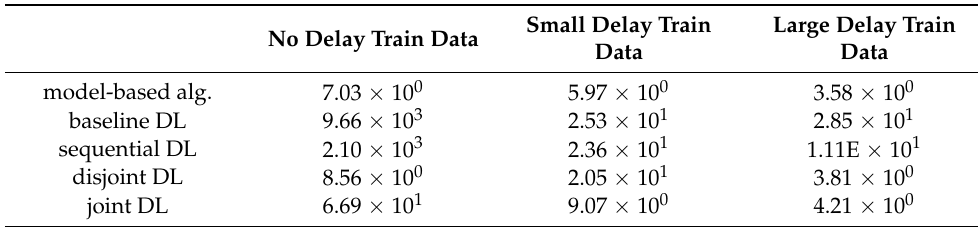
Table 4. Average mean square of displacement from the leader position over all simulation cases for different train data.